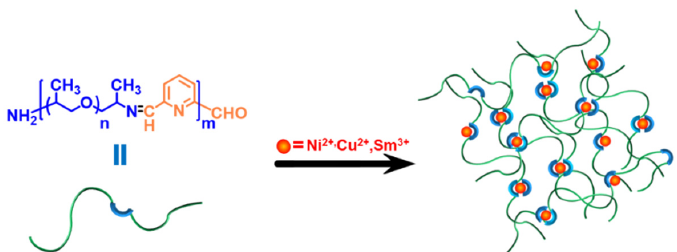
Scheme 2. Schematic structures of Schiff base coordination polymers.